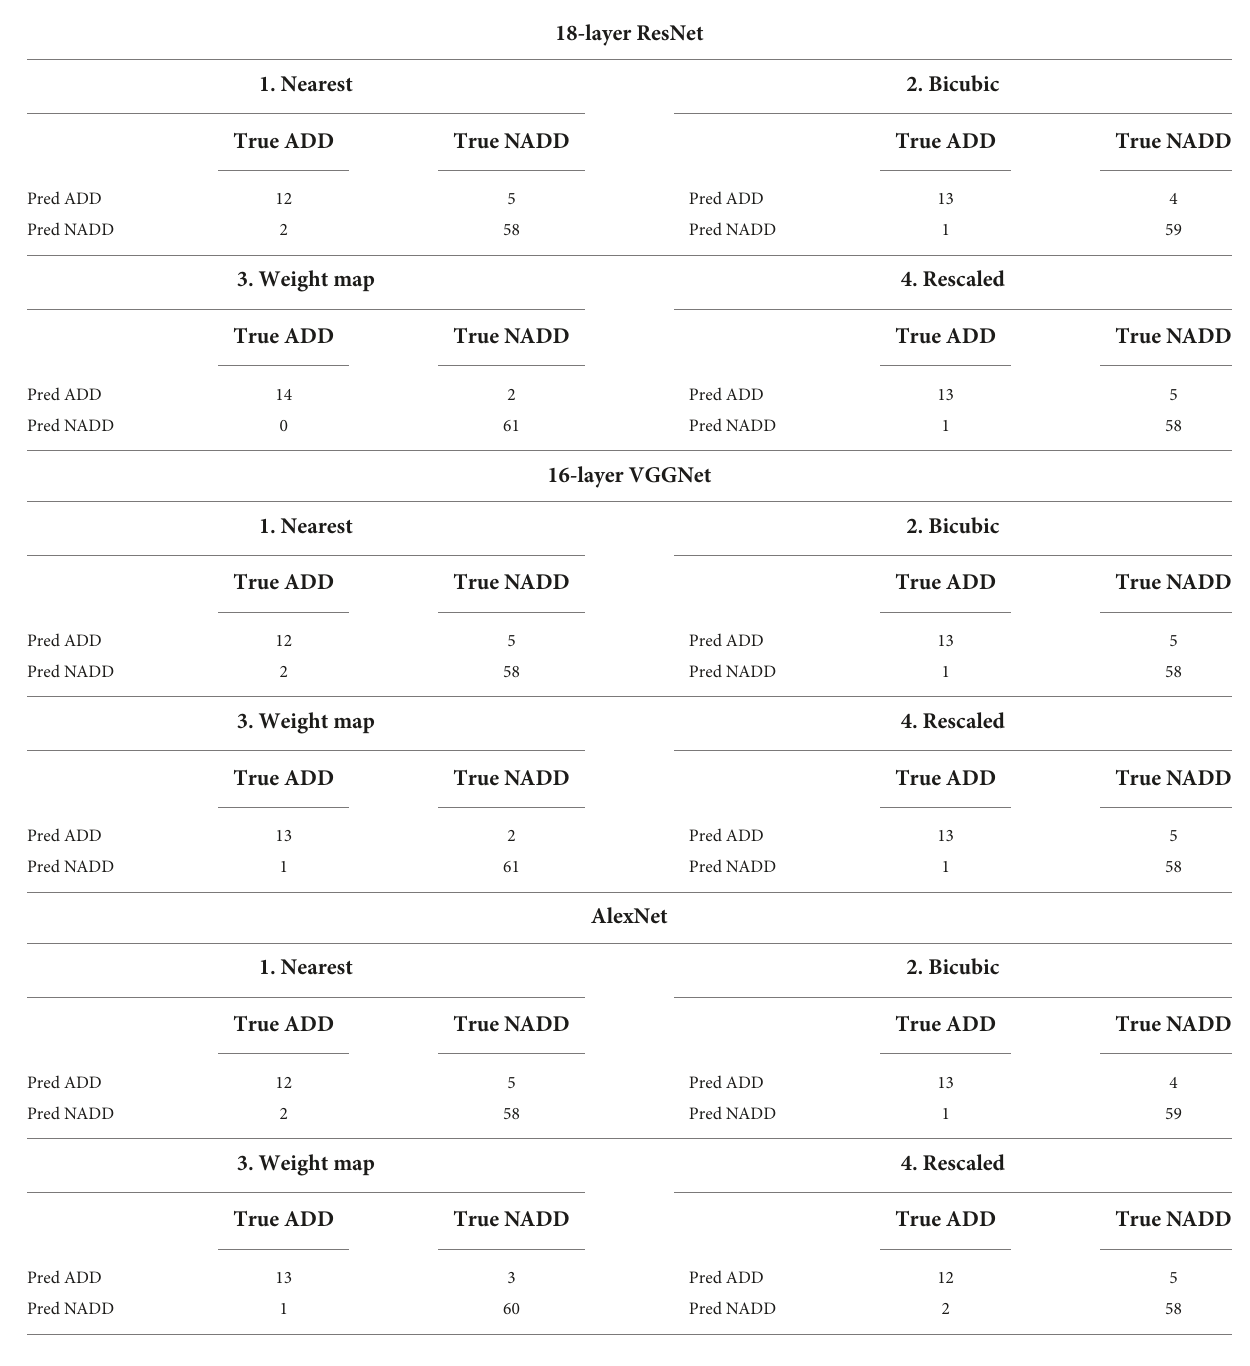
TABLE 3 Confusion matrices for selected best models trained with different types of image networks and images constructed through varying feature engineering